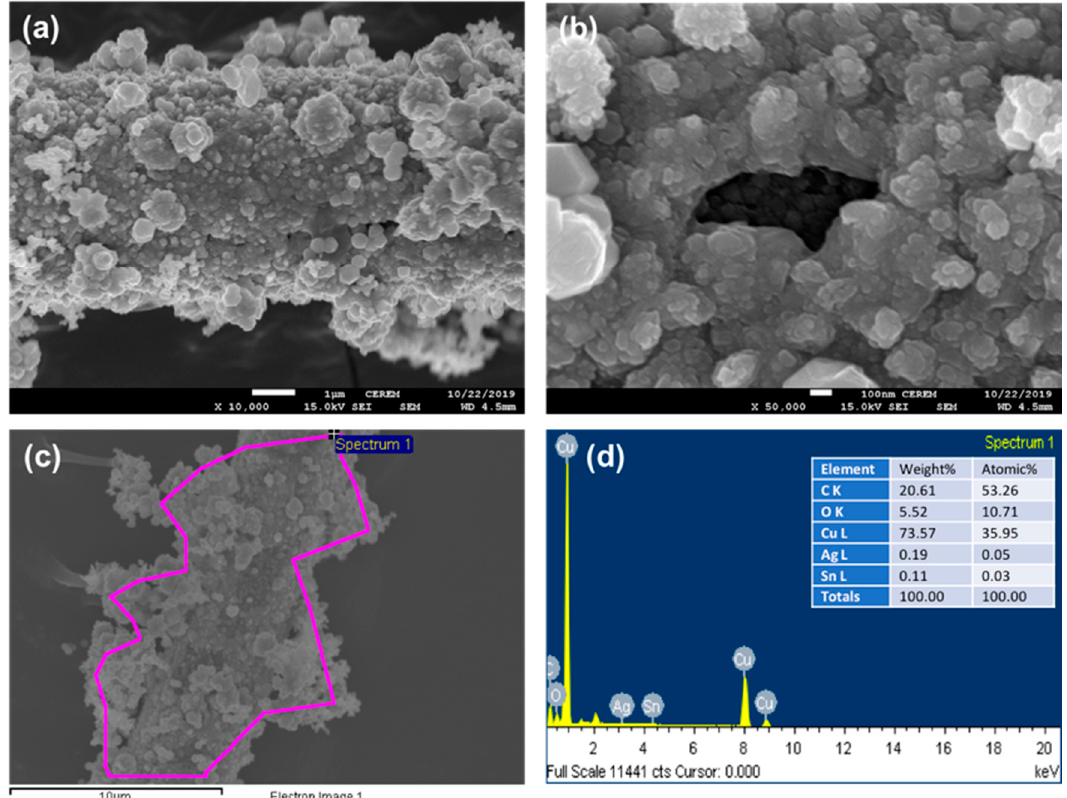
Figure 10. Carbon fibers activated via silver deposition followed by electroless copper deposition: ( a ) SEM image at low resolution; ( b ) SEM image at high resolution; ( c ) Selected area for EDAX analysis; and ( d ) EDAX elemental analysis.